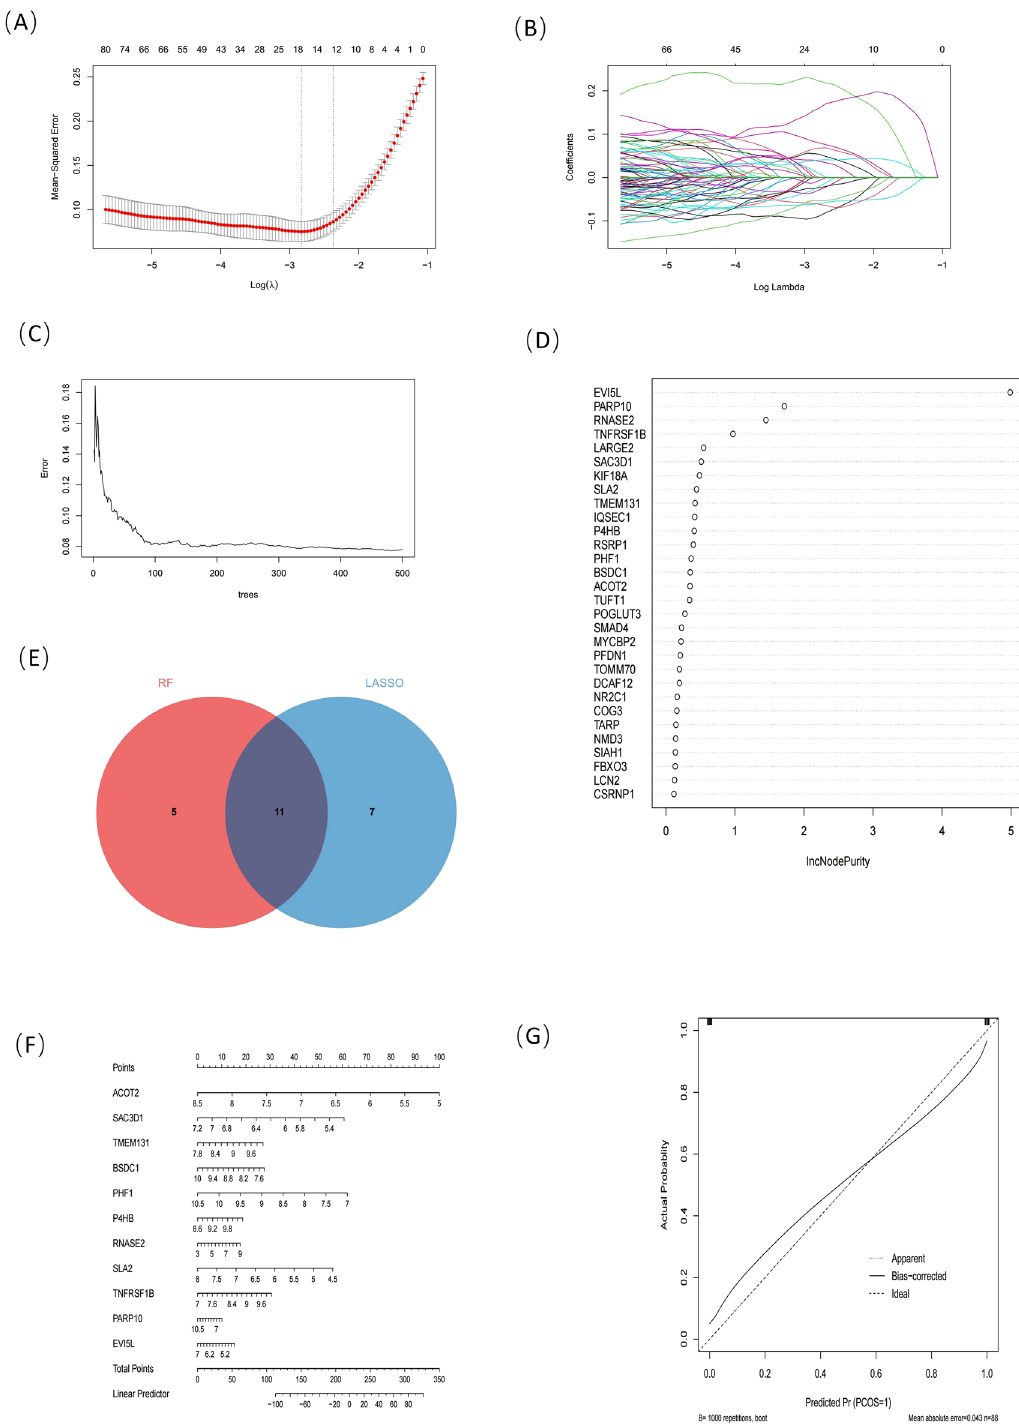
Figure 7. Machine learning. Drawn by R software program (version 3.40.6; R Foundation for Statistical Computing, Vienna, Austria, https:// www.r- proje ct. org/). ( A,B ) Genes are screened by the LASSO algorithm. In order to obtain the optimal model, the ten-fold cross-validation method is adopted. The lowest gene number n = 18 at the lowest point of the curve is best suited for LASSO. ( C,D ) Screen genes via random forest algorithm. The top 30 significant genes recognized from Random Forest. IncNodePurity rank the genes in accordance with their relative importance. ( E ) Venn plot of the intersection of two algorithms. ( F ) Nomogram for IPAH and MS diagnostics. ( G ) Nomogram’s calibration curve, Close to the diagonal indicates high